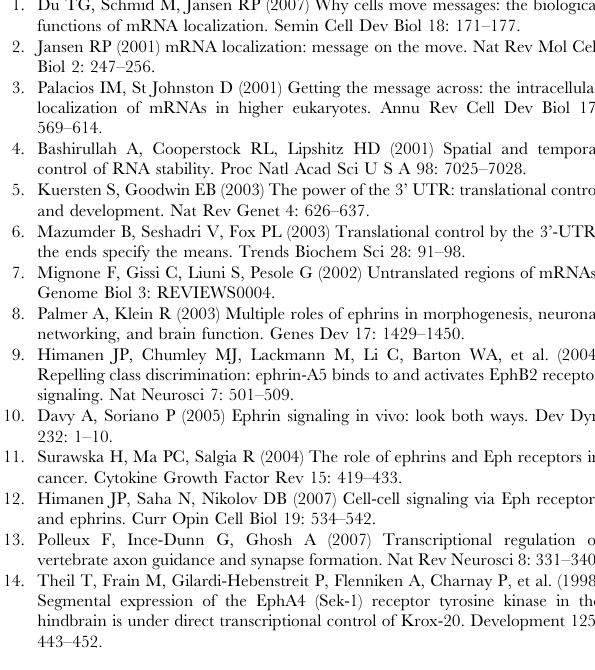
Table S4 Primers used for in vitro transcription